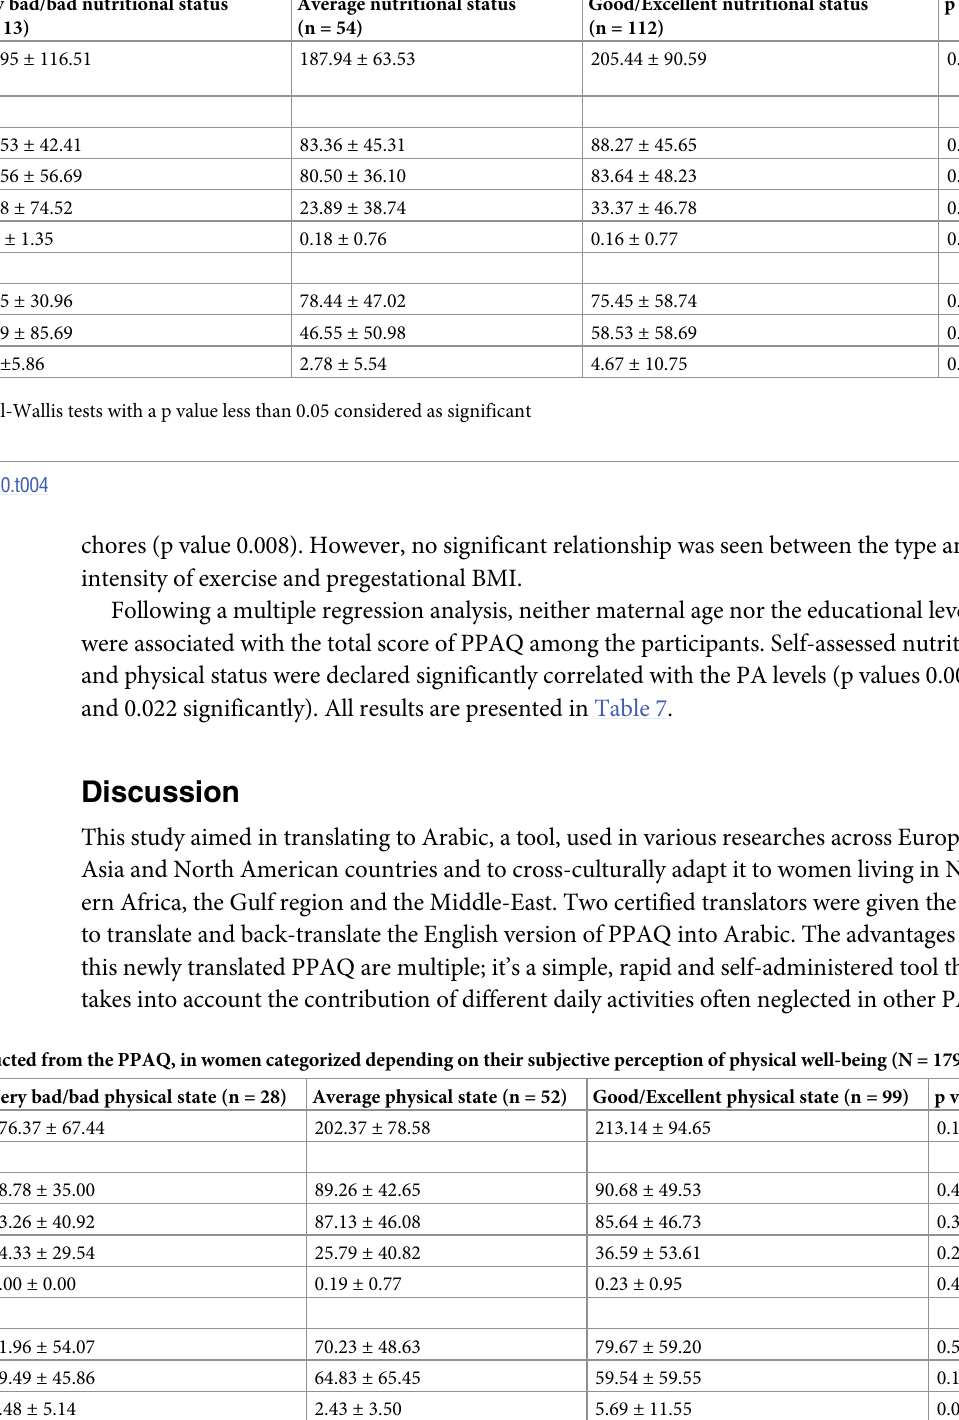
Table 4. Type and intensity of PA, deducted from the PPAQ, in women categorized depending on their subjective perception of nutritional status (N = 179). Very bad/bad nutritional status (n = 13)